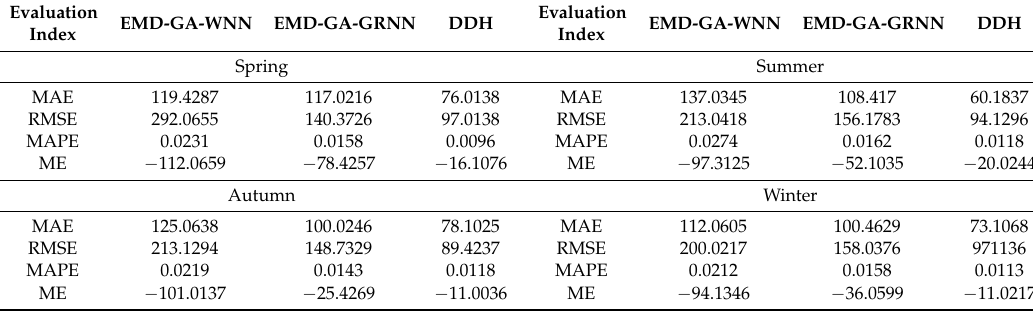
Table 5. Forecasting performance evaluation results of different seasons with a larger training